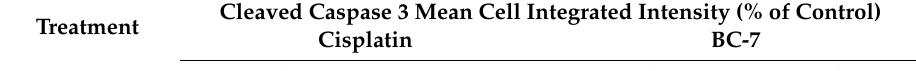
Table 6. Changes in cleaved caspase 3 levels in HeLa cells after 24 and 48 h of exposure to cisplatin and